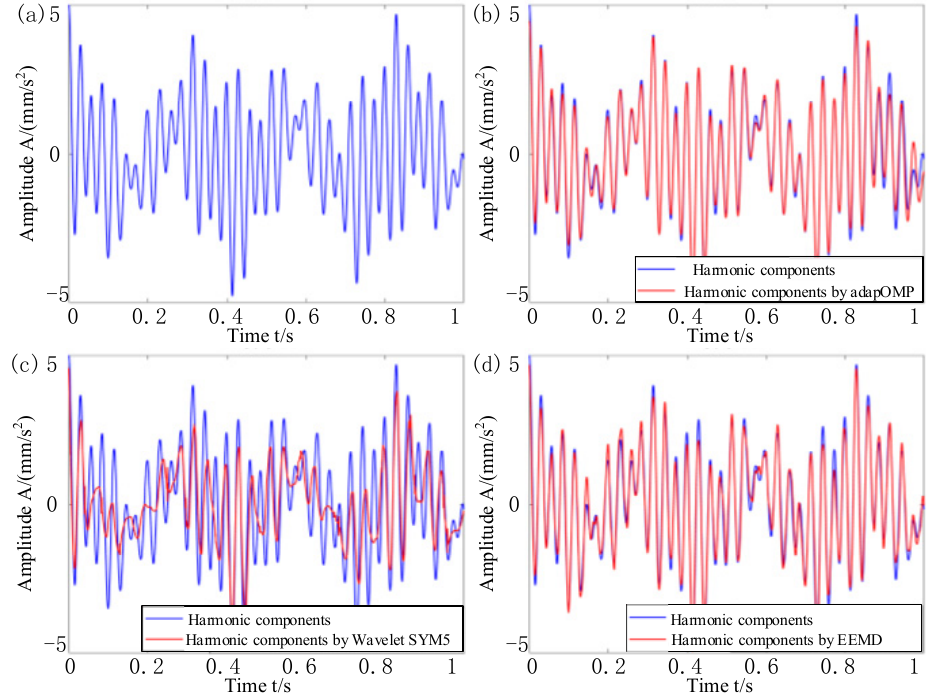
Figure 5. Different methods to extract harmonic components. ( a ) Harmonic components; ( b ) adapOMP extract harmonic components; ( c ) wavelet SYM5 decomposition extract harmonic components; ( d ) EEMD extract harmonic components. Table 1. Performance of different methods of extracting harmonic components.